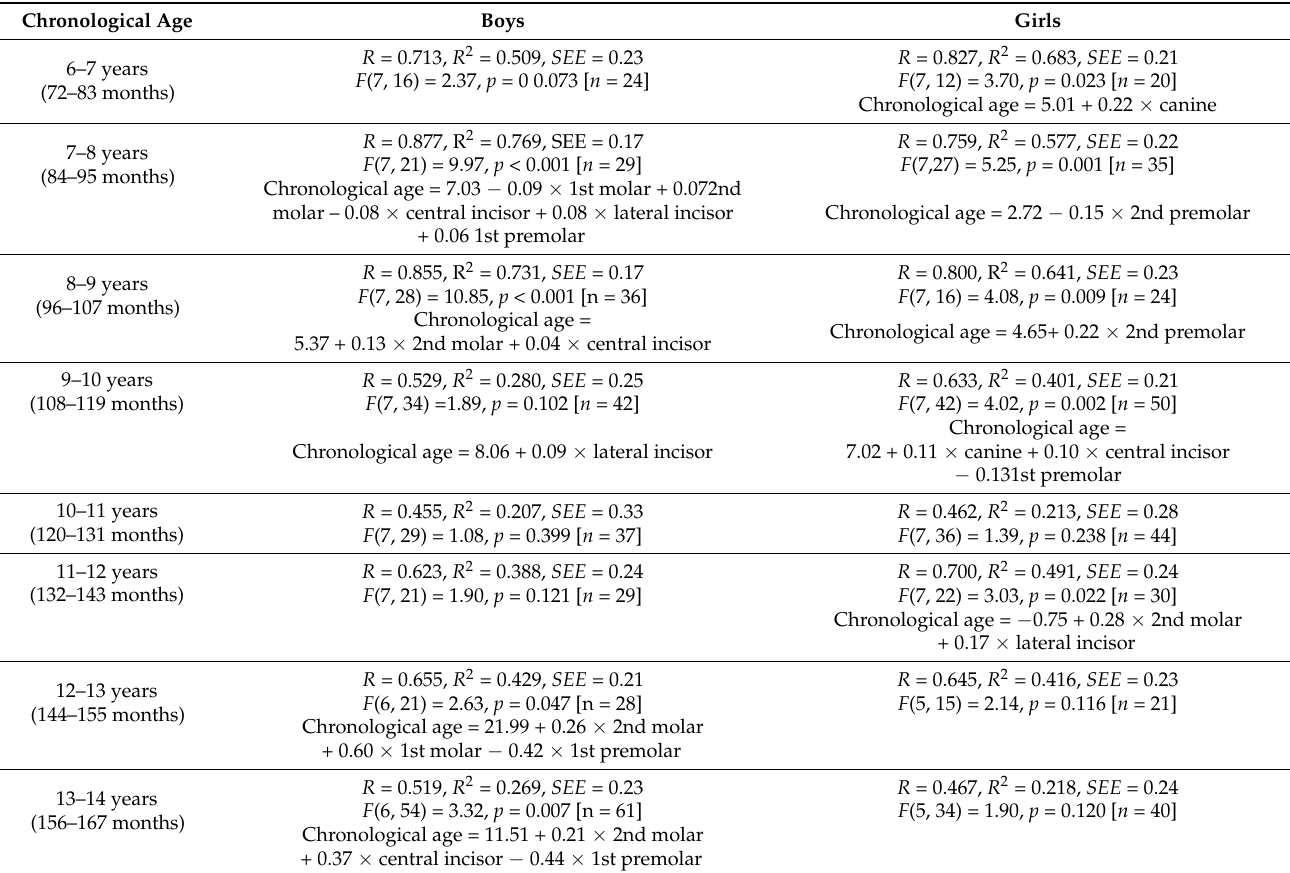
Table 5. Regression analysis for boys and girls according to age group (estimation in years; regression equations for significant teeth, p <